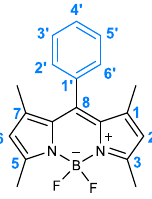
Figure 1. Structure of BODIPY derivative 1 .